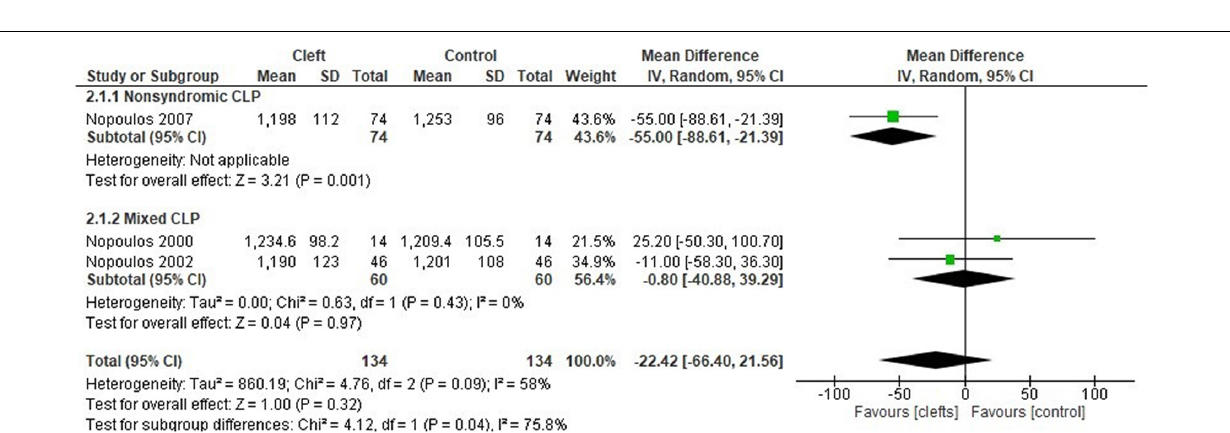
FIGURE 3 | Forest plot for total brain volume (cm 3 ) with subgroup analysis (non-syndromic vs. mixed).